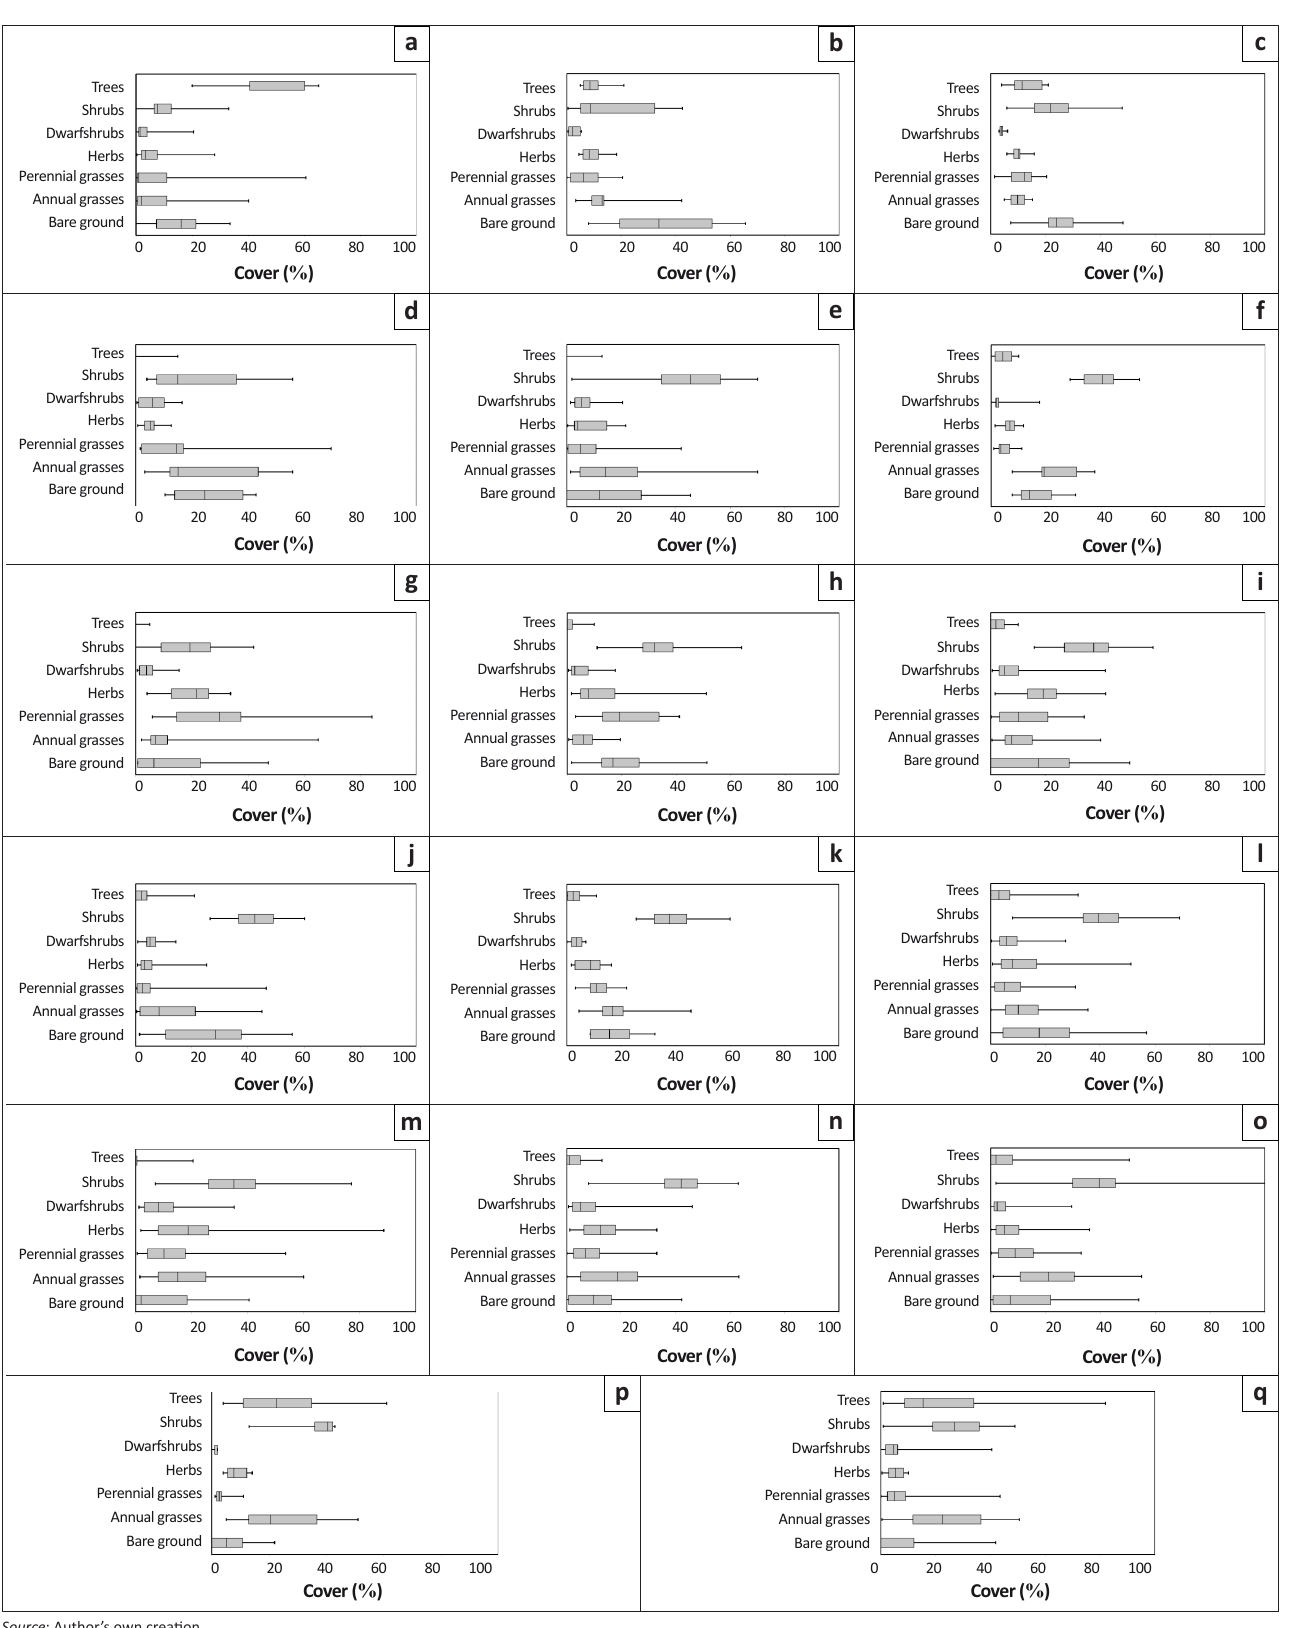
FIGURE 3: Box-and-whisker plots of the typical structure of the various associations and subassociations, (a) Acacio fleckii–Terminalietum prunioidis , (b) A cacio tortilis–Combretetum imberbis , (c) Ptycholobio biflori–Acacietum luederitzii, (d) Eragrostio echinocloideae–Eriocephaloetum luederitziani , (e) Ac